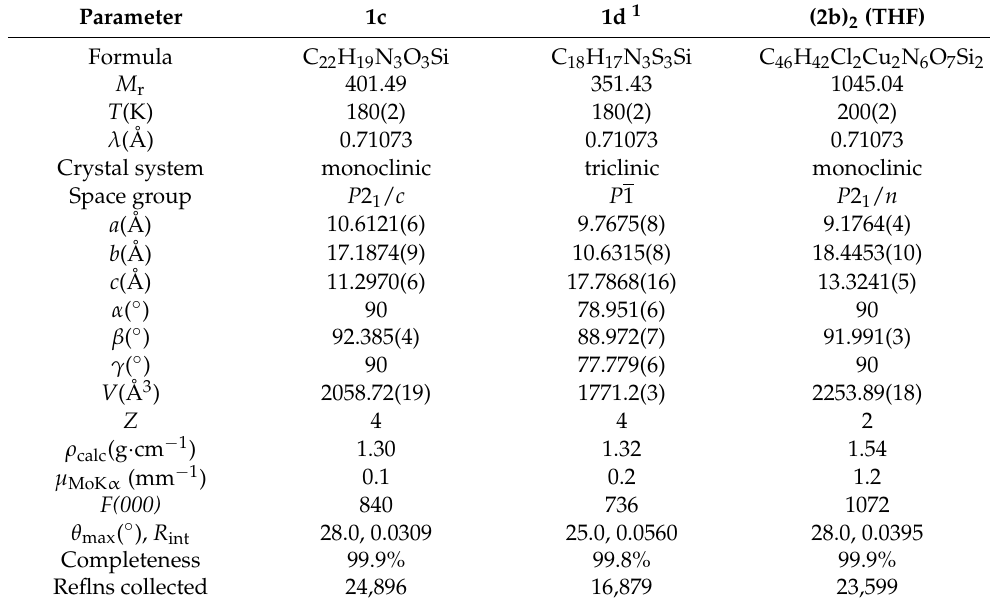
Table A1. Crystallographic data from data collection and refinement for 1c , 1d and ( 2b ) 2 (THF).